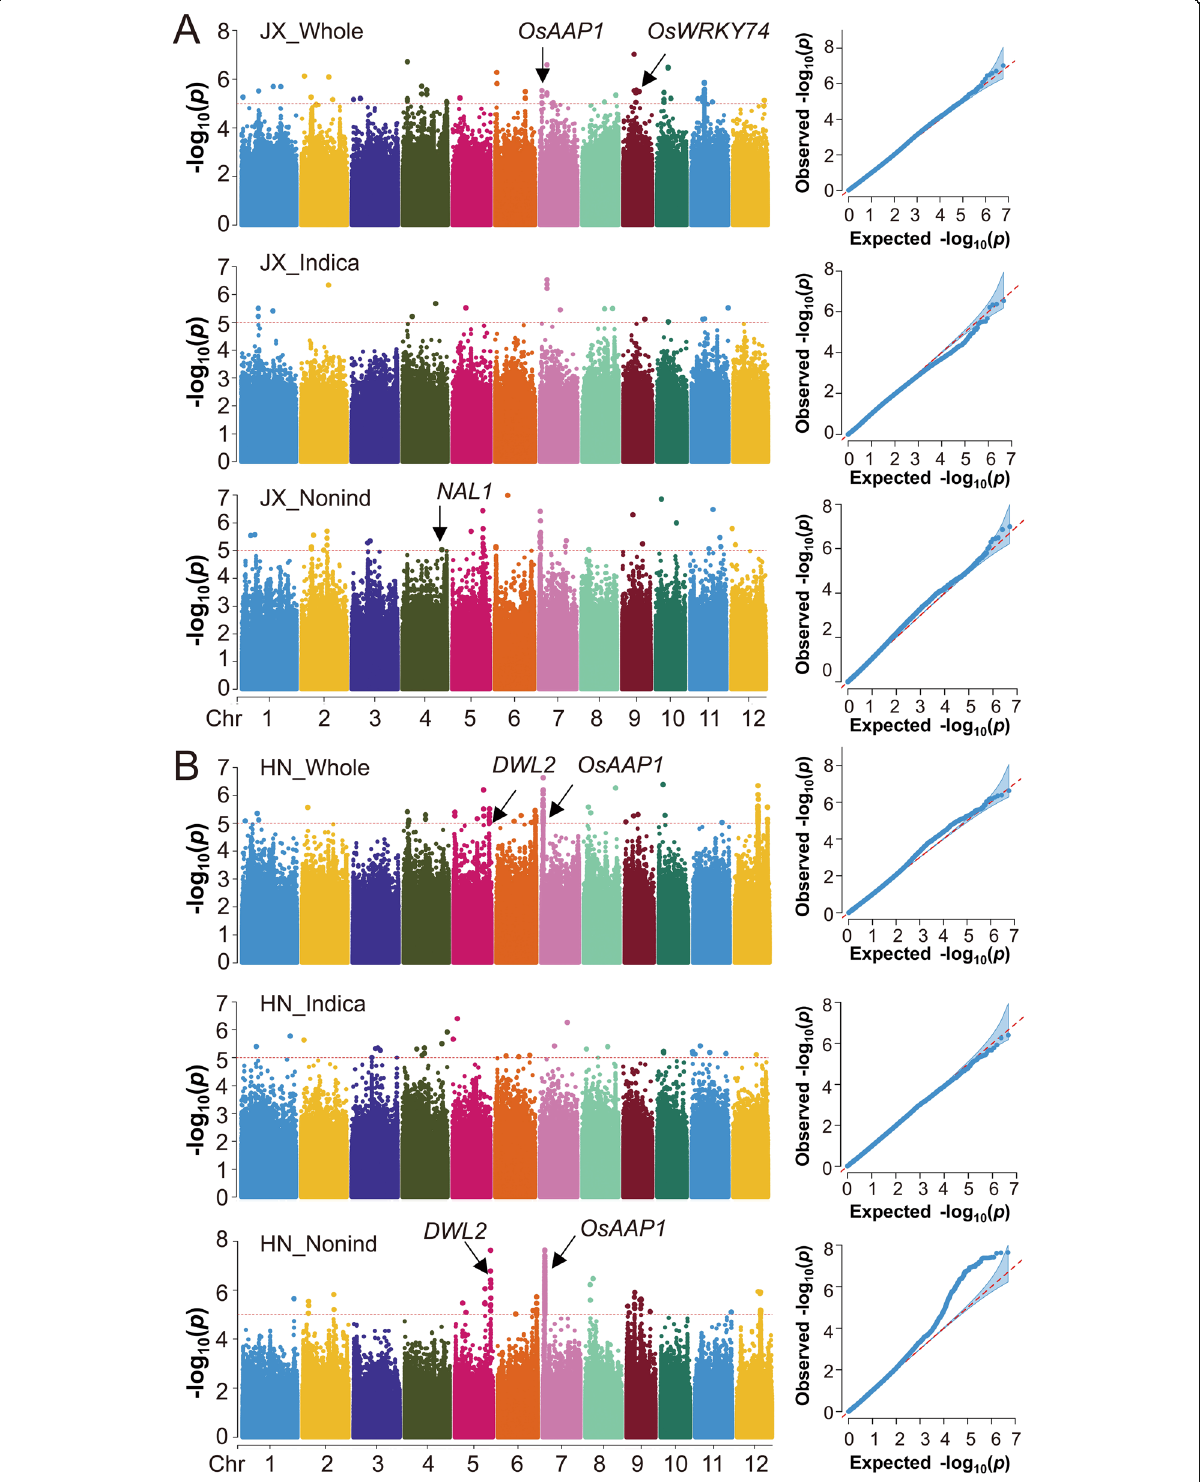
Fig. 2 Manhattan plots and quantile-quantile (Q-Q) plots of six GWAS assays. ( a ) GWAS assays for the whole, indica and nonind population using ETN data in Jiangxi, ( b ) GWAS assays for whole, indica and nonind population using ETN data in Hainan. Some candidate genes are indicated using arrow